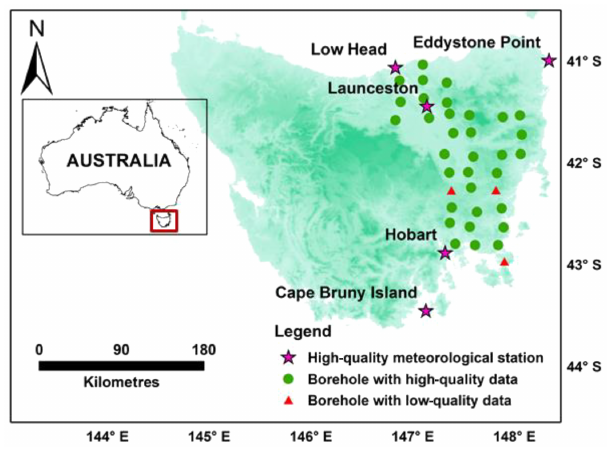
Figure 1. Location of 36 boreholes sites in Tasmania. High-quality ACORN-SAT (Bureau of Meteorology, 2016b) meteorological sta- tions are shown by stars.